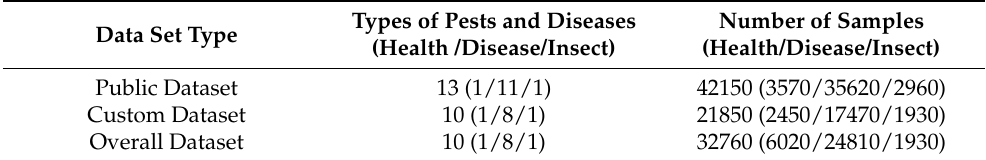
Figure 2. Grape pest and disease samples from overall dataset. Table 1. Three types of dataset characteristics.